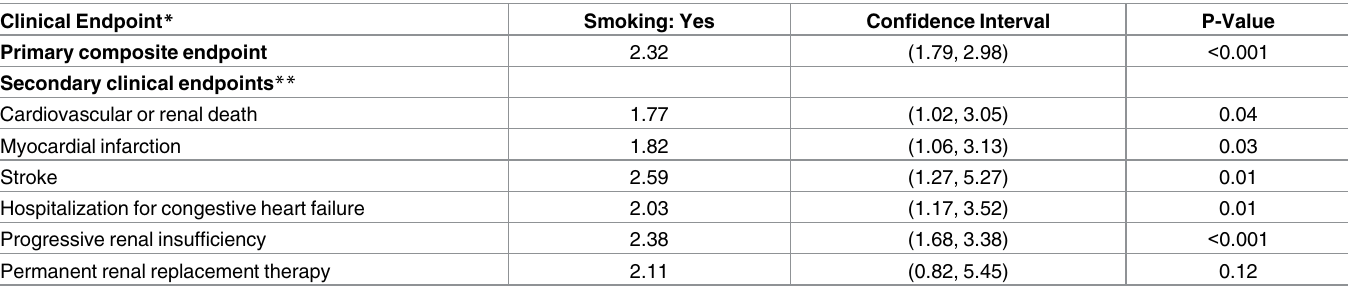
Table 3. Clinical events comparing smokersand non-smokers adjusted for sex, ethnicity and BMI using age-at-event (years)as the response. Clinical Endpoint